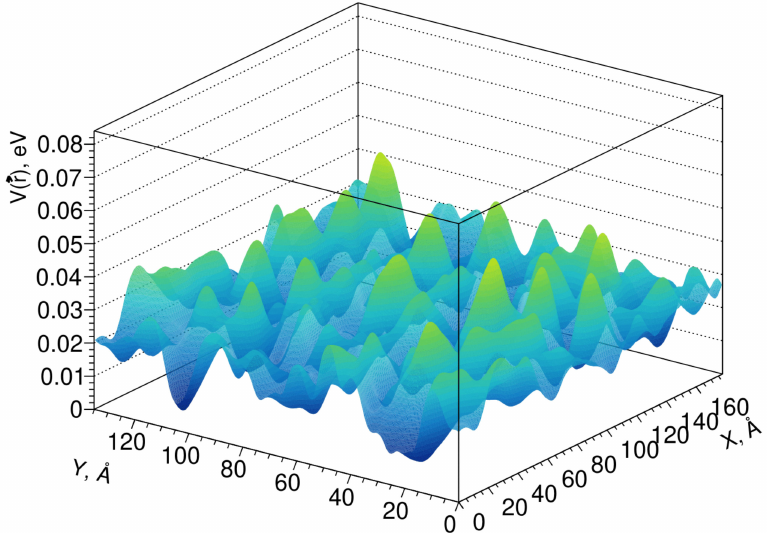
Figure 4. Profile of fluctuations of the conduction band edge in a Lu 1.6 Y 0.4 SiO 5